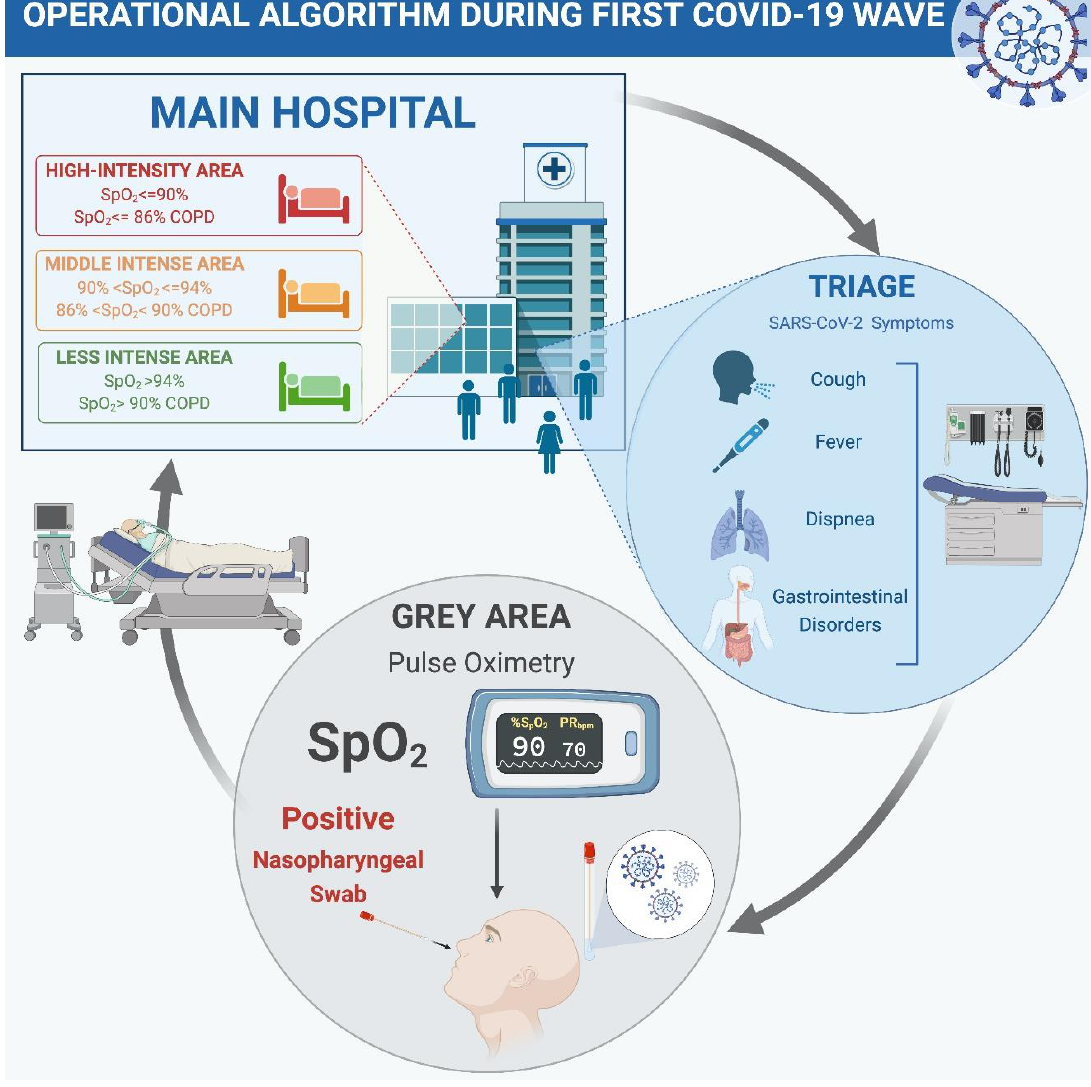
Figure 1. Operational algorithm used during the first wave of COVID-19.